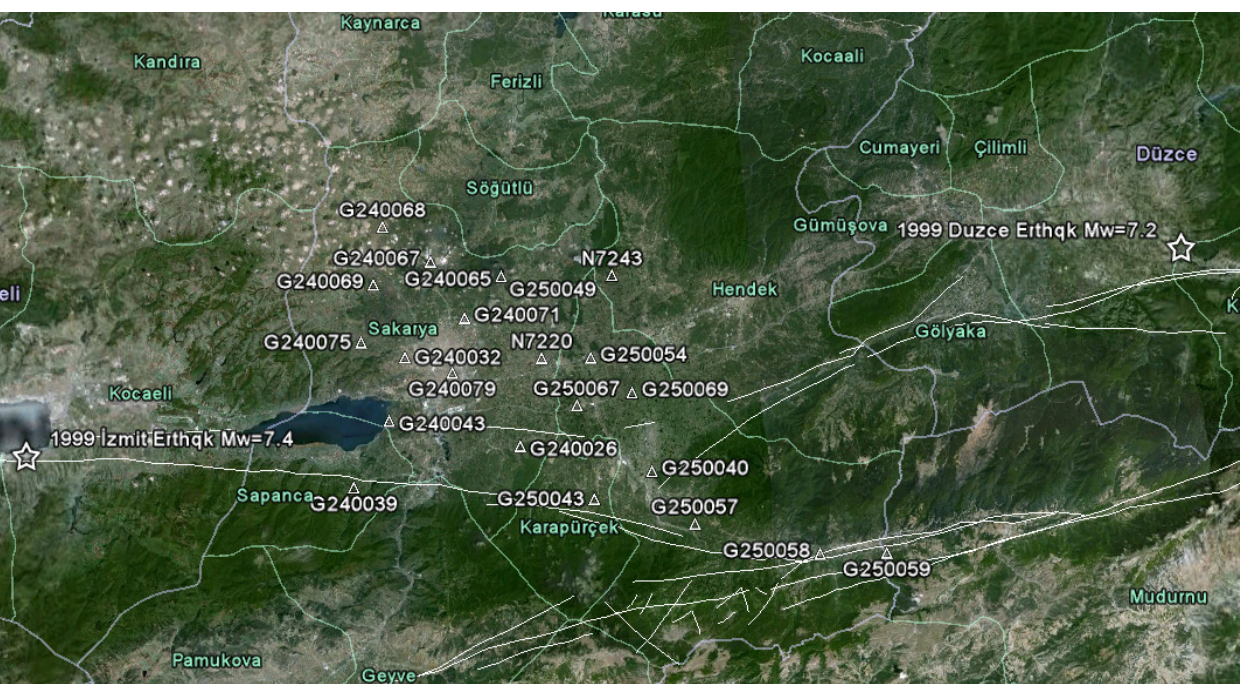
Fig. 4. Sakarya geodetic control network. Triangles display the network control stations. Stars show the location of the earthquakes. Solid white lines represent the fault lines (Satellite image from Google Earth).